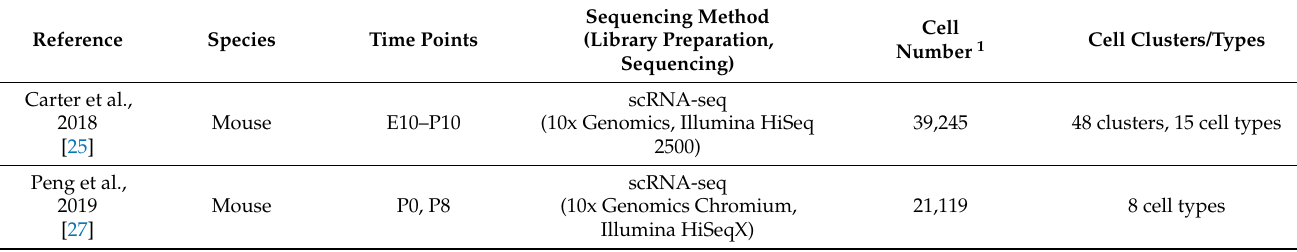
Table 1. Recently published single-cell and single-nucleus RNA-sequencing datasets from the de- veloping and adult cerebellum. E, embryonic days post-conception (mouse, opossum); INTACT, isolation of nuclei tagged in specific cell types; P, days after birth (mouse); pcw, post conception weeks (human); snATAC-Seq, single-nucleus assay for transposase-accessible chromatin sequencing; scRNA-seq, single-cell RNA-sequencing; snRNA-seq, single-nucleus